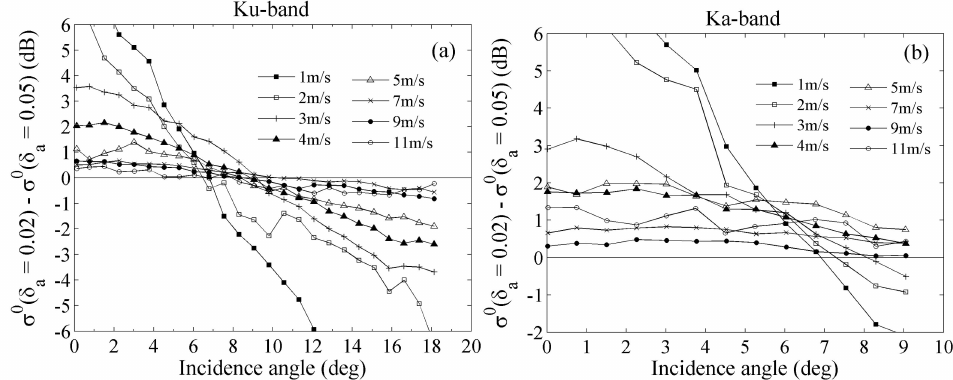
Figure 14. Magnitude of the difference of ( a ) KuPR σ 0 , ( b ) KaPR σ 0 between different average wave steepnesses ( δ a = 0.02 and δ a = 0.05) as functions of incidence angle for different wind speeds from light to moderate